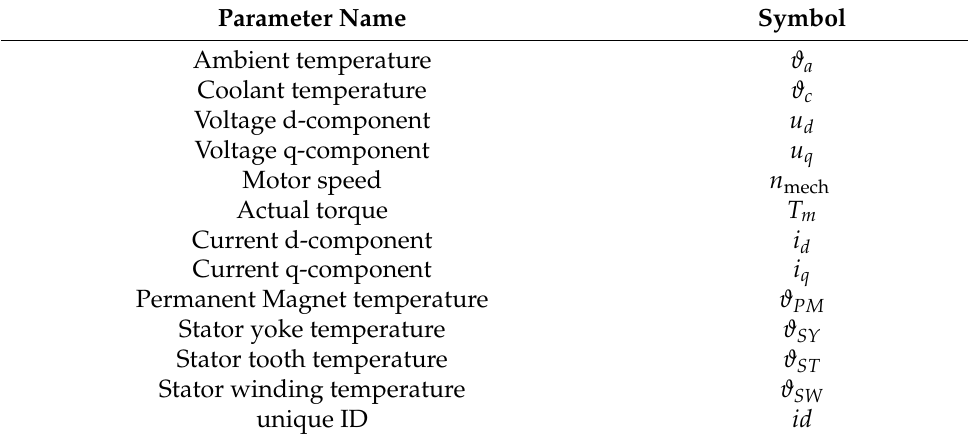
Table 1. The column labels of the benchmark